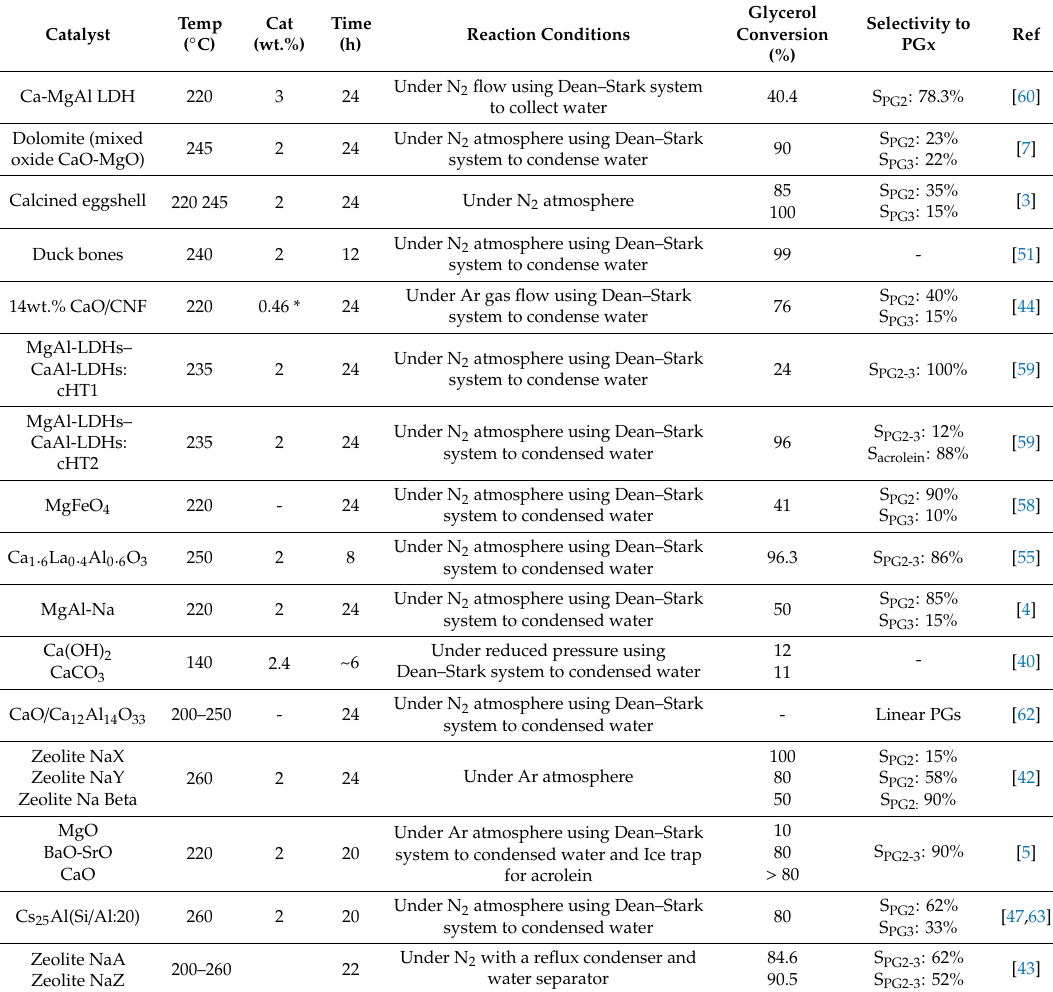
Table 3. Summary of the conditions and performances obtained for glycerol polymerization over heterogeneous